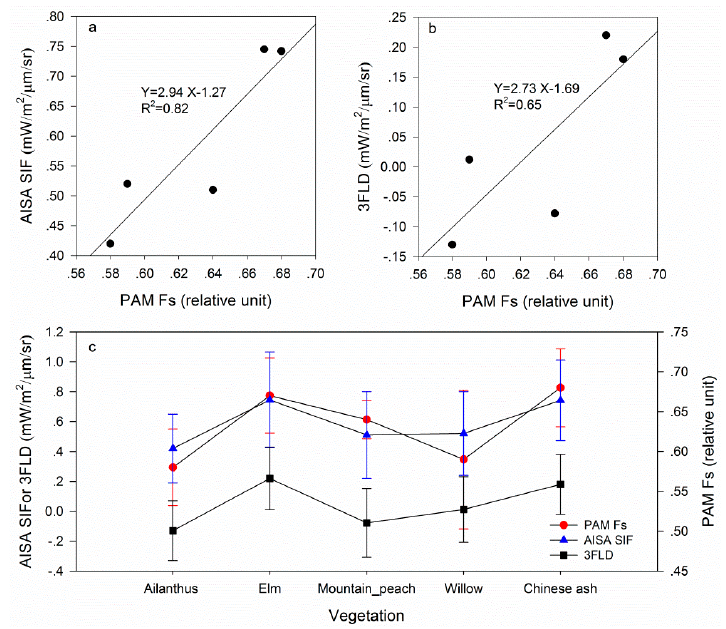
Figure 8. Comparison between AISA SIF and PAM Fs: a is the relationship between AISA SIF and PAM